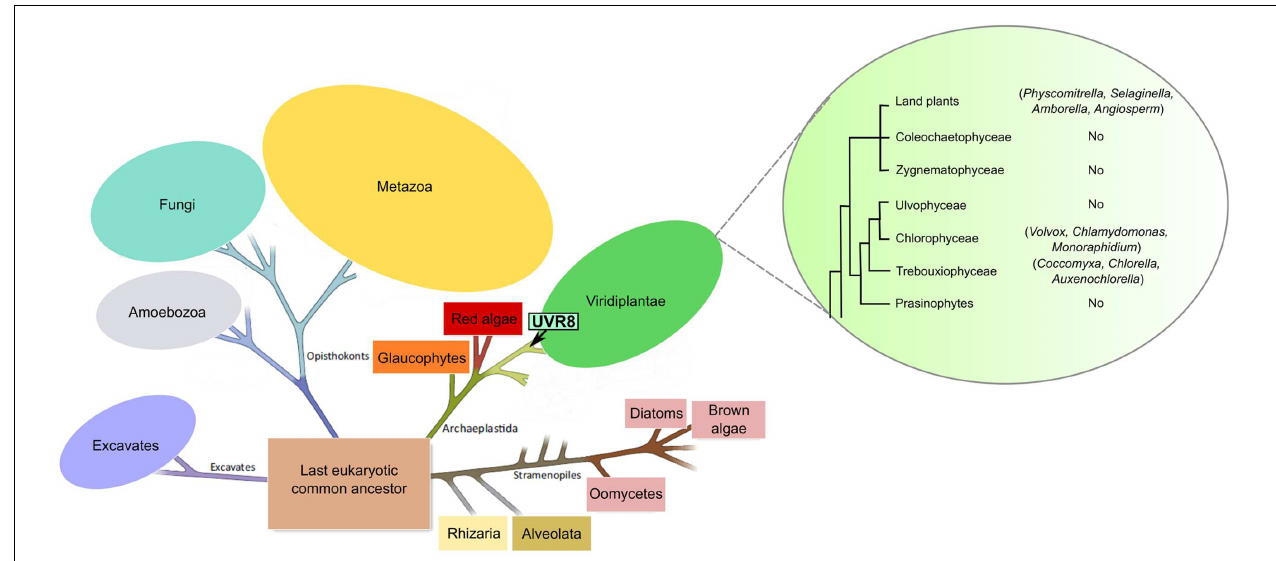
FIGURE 1 | Distribution of At UVR8 homologs in the Tree of Life. Schematic representation of the eukaryotic tree of life and the Viridiplantae group illustrating the evolution of the UVR8 gene. The arrow indicates the origin of the UVR8 photoreceptor in the Viridiplantae clade. Taxons where this protein was identified are indicated in parenthesis after the name of each group. The image has been taken and adapted from Jeandroz et al. (2016) and Rensing